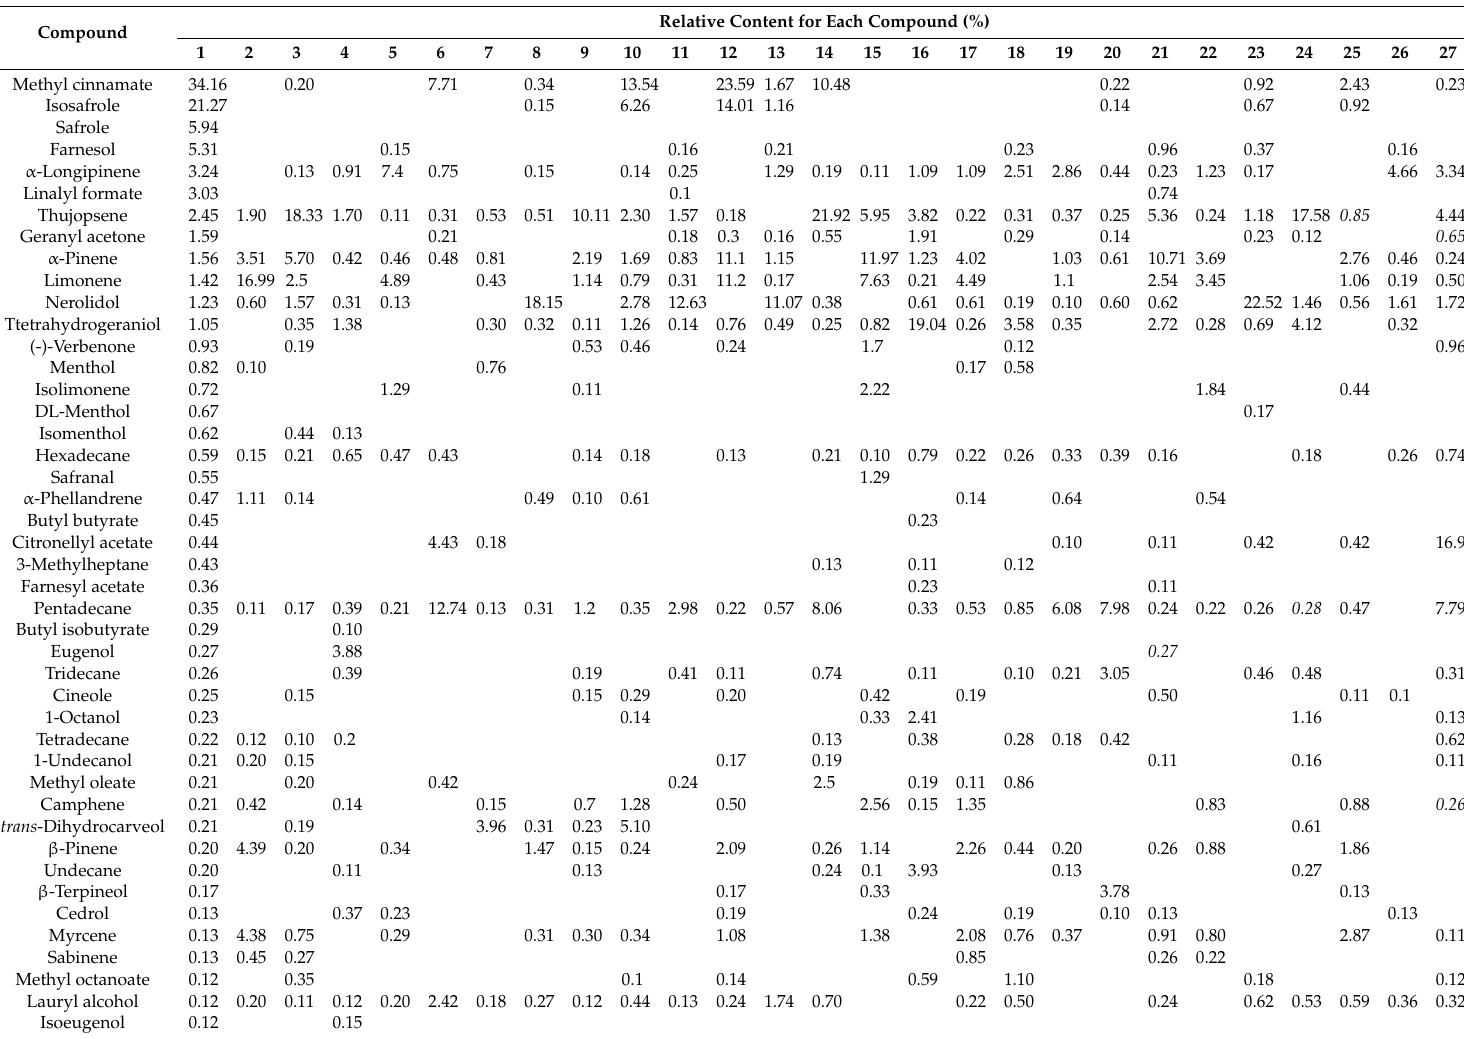
Table 1. Floral scent compounds and relative contents emitted from twenty-seven bearded iris